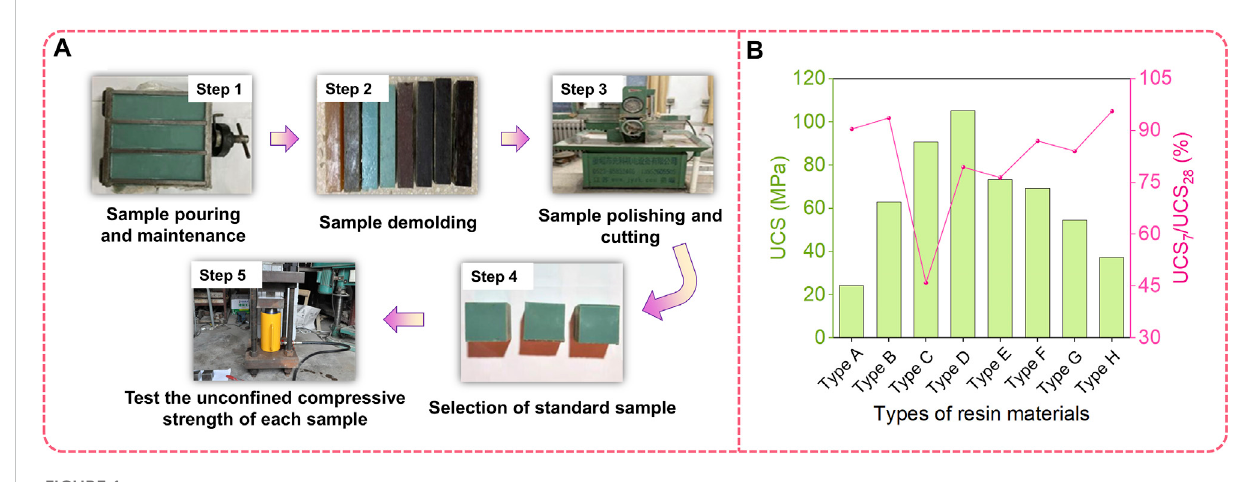
FIGURE 1 UCS test preparation steps and testresults of different loading transfermaterials: (A) UCS test preparationsteps, (B) UCS test results of eight loading transfer